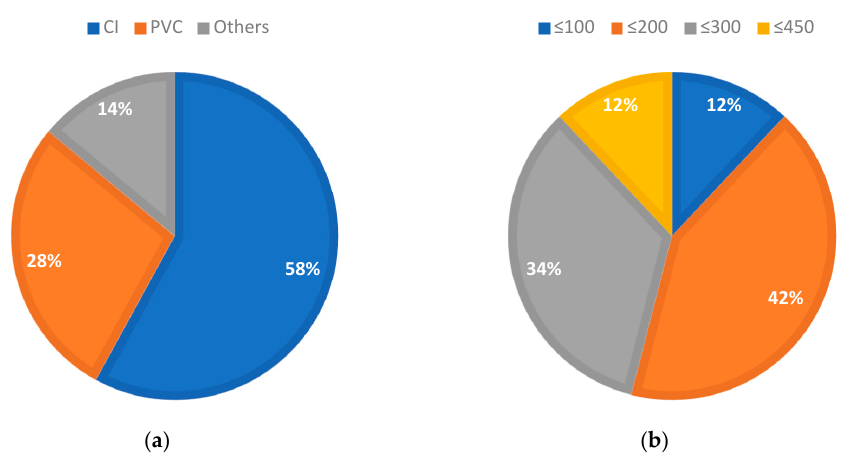
Figure 8. LWDN characterization through distribution of pipe: ( a ) material; ( b ) diameter (mm).